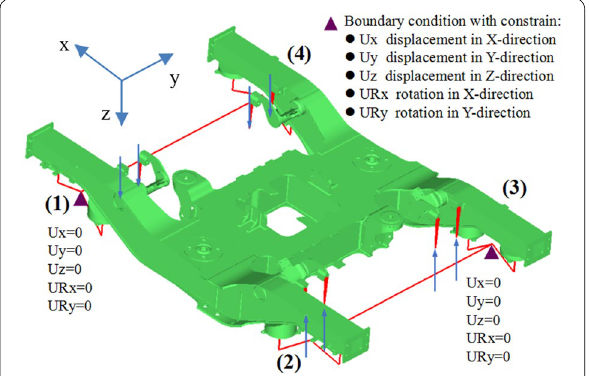
Figure 2 Bogie frame structure with braking forces and boundary conditions